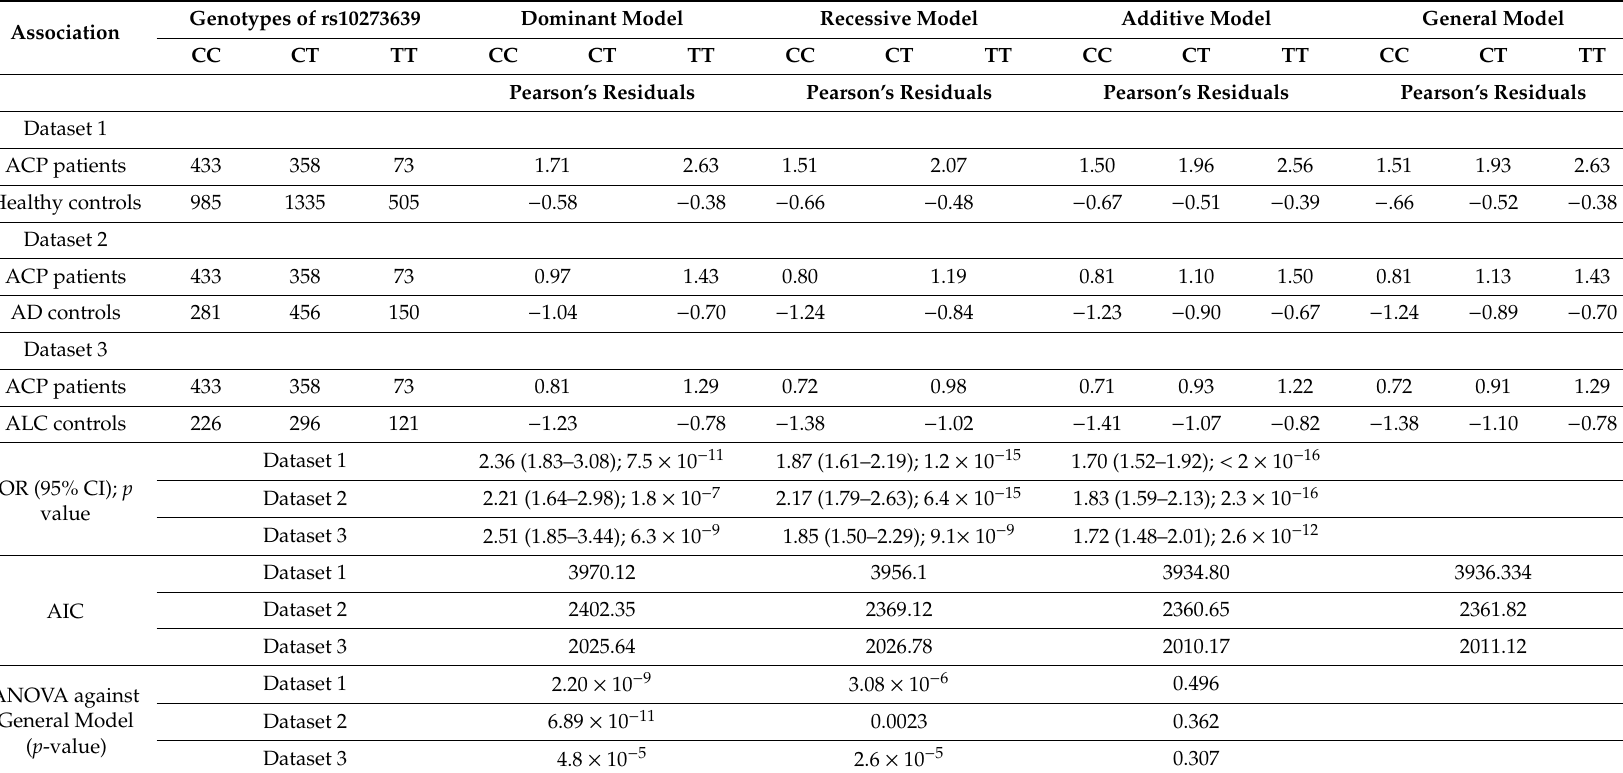
Table 4. Test of the fit of di ff erent genetic models to three German ACP association datasets